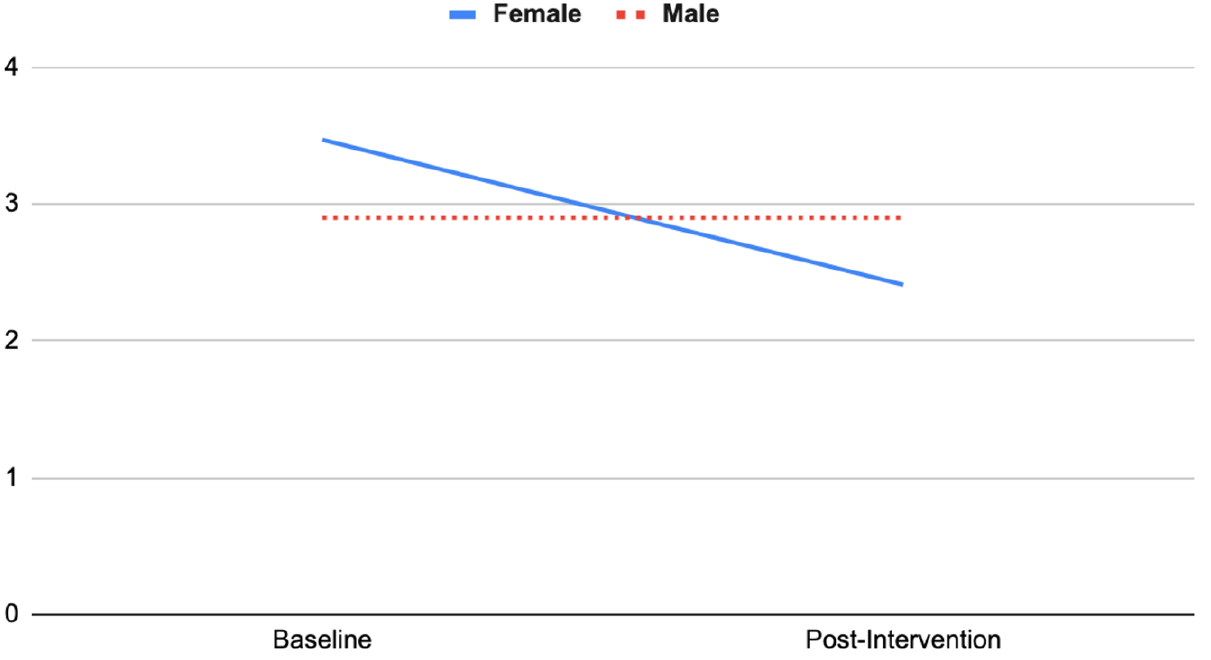
Figure 2. Interaction effect between gender and scepticism.